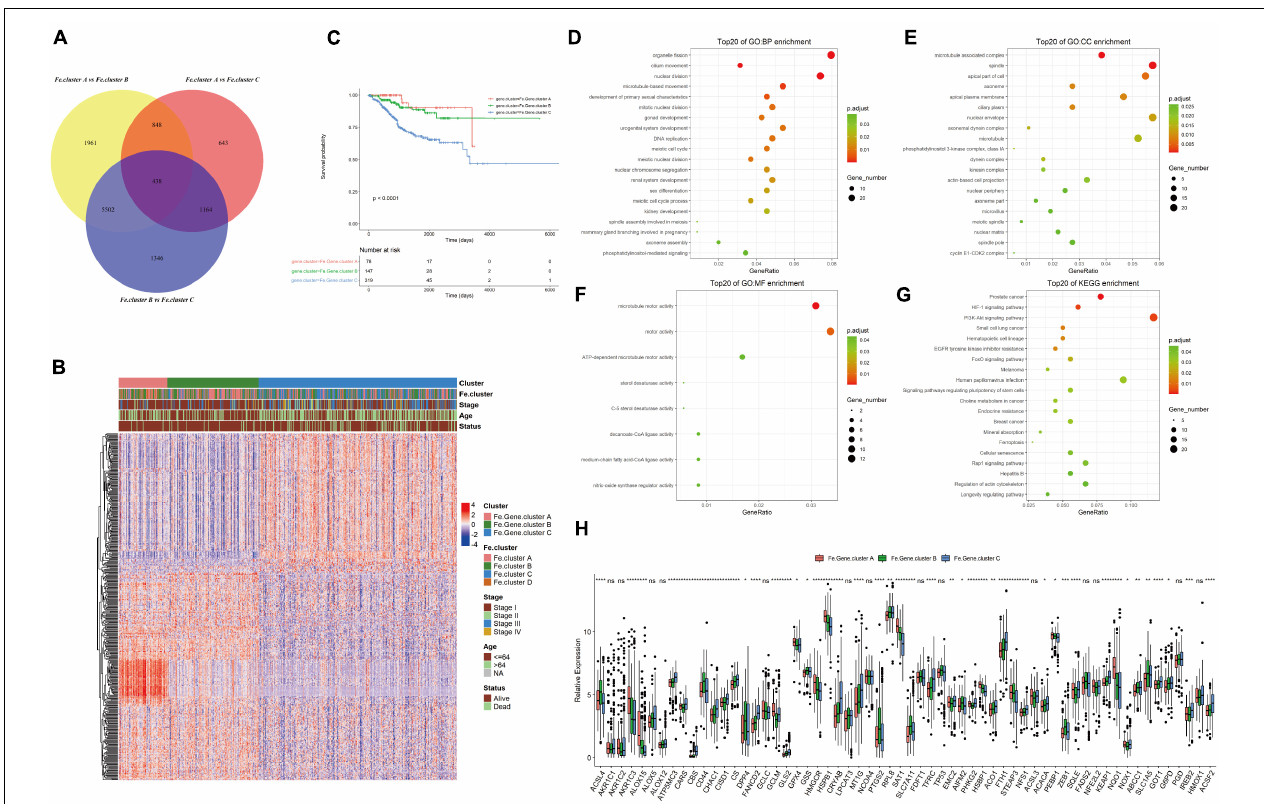
FIGURE 4 | Molecular expression and prognosis of Fe.gene.clusters. (A) Total of 438 overlapping differential genes obtained from Fe.clusters. (B) Expression heat map of 438 overlapping differentially expressed genes among Fe.clusters. (C) Kaplan–Meier survival curve of Fe.gene.clusters. (D) The Gene Ontology (GO) enrichment results of biological processes of overlapping differentially expressed genes in ferroptosis clusters. The color indicates a significant degree of enrichment, the size of the bubble indicates the number of differential genes enriched in the pathway, and the abscissa indicates the proportion of genes. (E) The GO enrichment results of cell components. (F) The GO enrichment results of molecular function. (G) The KEGG enrichment pathways. The color indicates the significant degree of enrichment, the size of the bubble indicates the number of differential genes enriched in the pathway, and the abscissa indicates the proportion of genes. (H) The box plot shows the expression differences of 60 ferroptosis genes among the Fe.gene.cluster groups. Ns, p > 0.05, * p < 0.05; ** p < 0.01; *** p < 0.001; **** p < 0.0001.